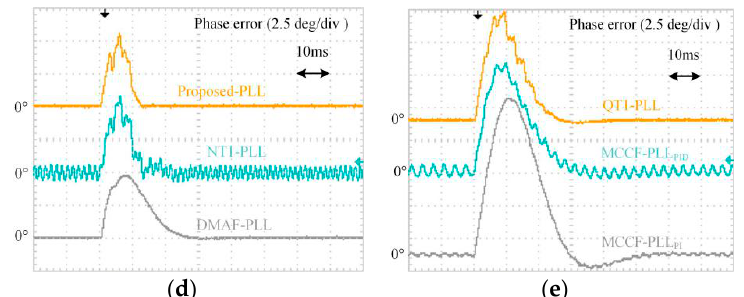
Figure 25. Experimental waveforms under distorted voltage condition with a +5 Hz frequency jump: ( a ) Three-phase voltages; ( b , c ) Estimated frequency; ( d , e ) Phase error. With the help of adaptive MAF and ANF, the oscillations under 50 Hz and 55 Hz are totally